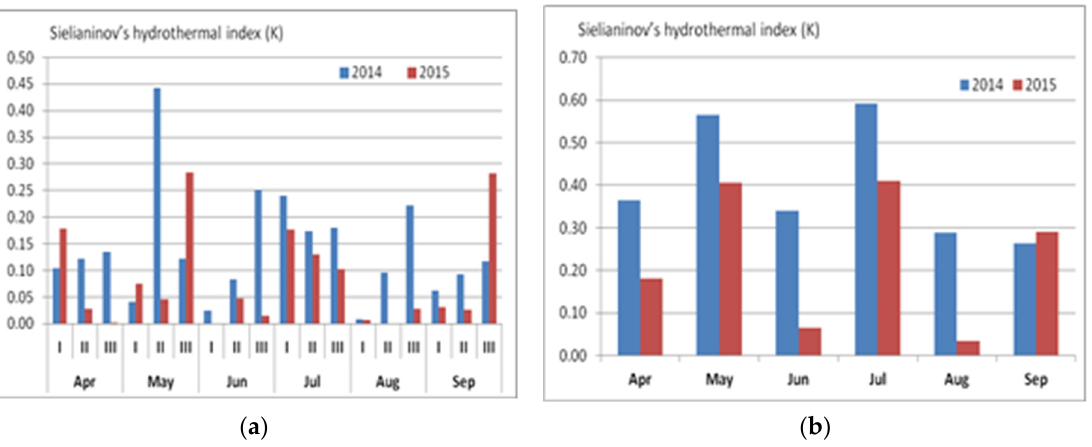
Figure 3. Sielianinov’s hydrothermal index K t in growing season of soybean ( a ) in decades and ( b ) in months.